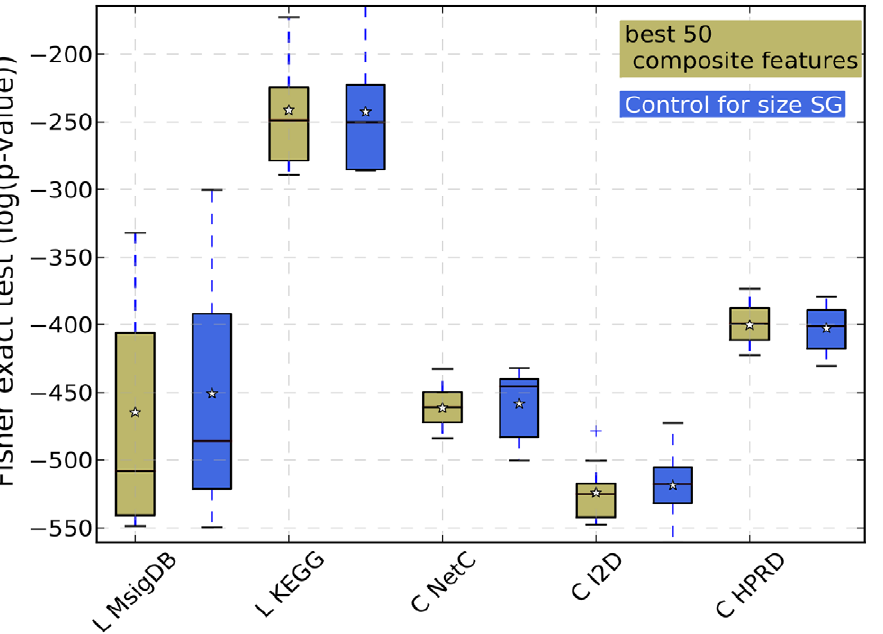
Figure 9. Feature stability when corrected for gene set size. Box plots of the p-values of the Fisher exact test computed for all pairs of gene sets derived from two different data sets. The green box plots represent the values for genes constituting composite features, while the blue box plots (denoted as ‘Control for size SG’) represent the gene-size-corrected values for single genes classifiers. The white stars represent the means of the distributions.